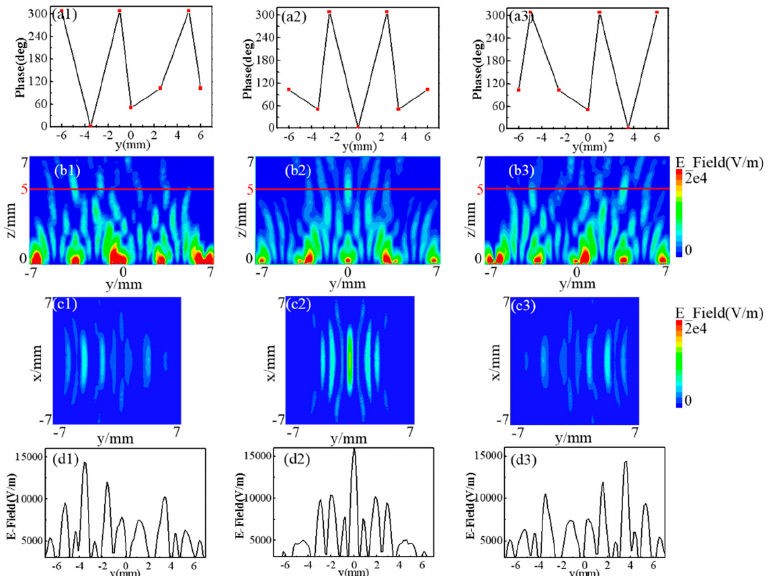
Figure 6. The phase distribution for beam focusing on the ( a1 ) left, ( a2 ) middle and ( a3 ) right sides of the y-z plane. ( b1 – b3 ) and ( c1 – c3 ) show the electric field intensity distribution focusing on the left, middle and right sides in the y-z and x-y plane, respectively. ( d1 – d3 ) The extracted field intensities along the red line in ( b1 – b3 ).